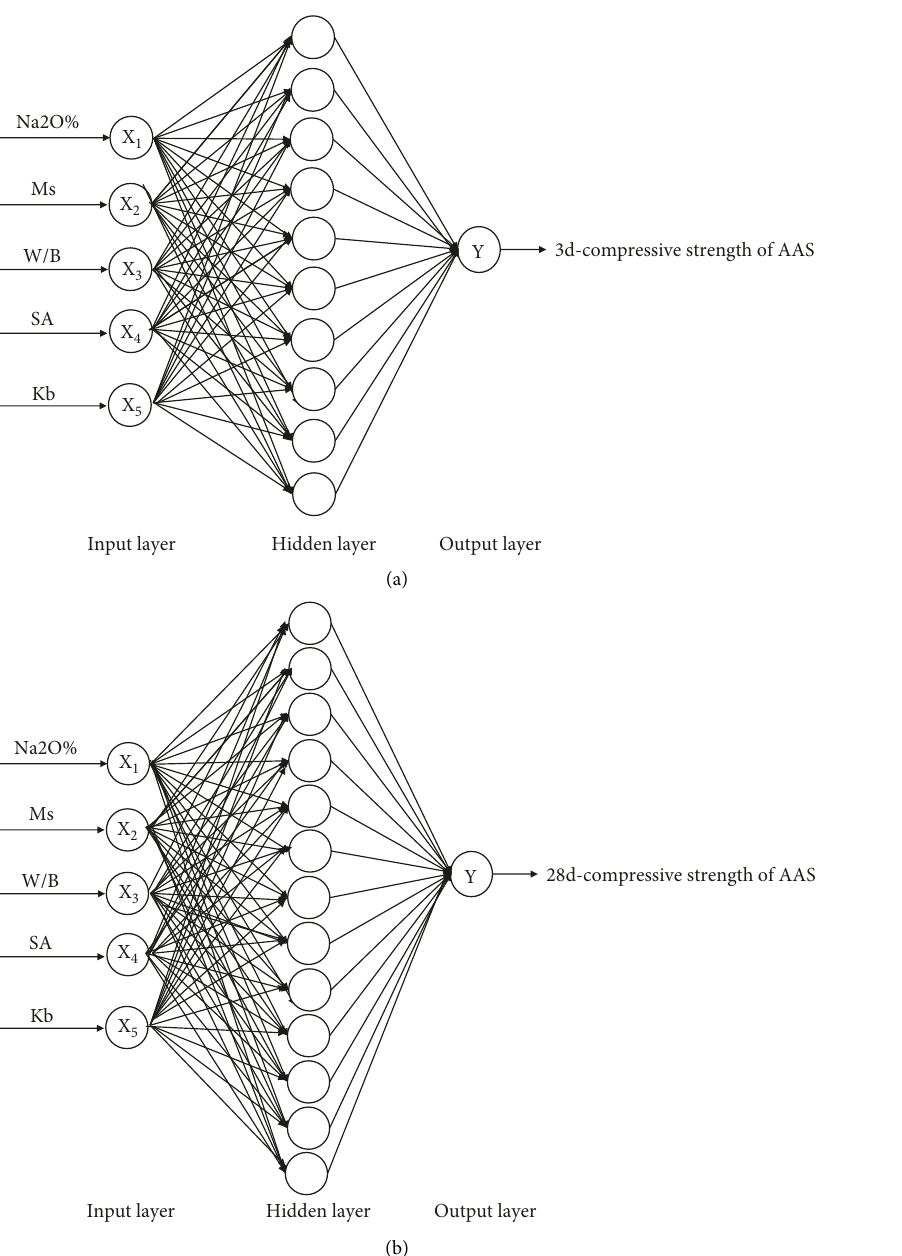
Figure 1: ANN model structures used in this study: (a) 5-10-1 structure for 3d compressive strength. (b) 5-13-1 structure for 28d compressive